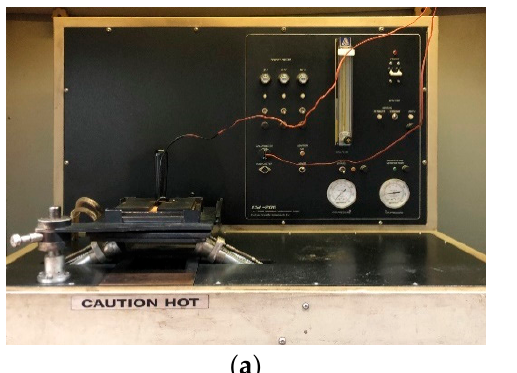
Table 1. Basic properties of the specimens.